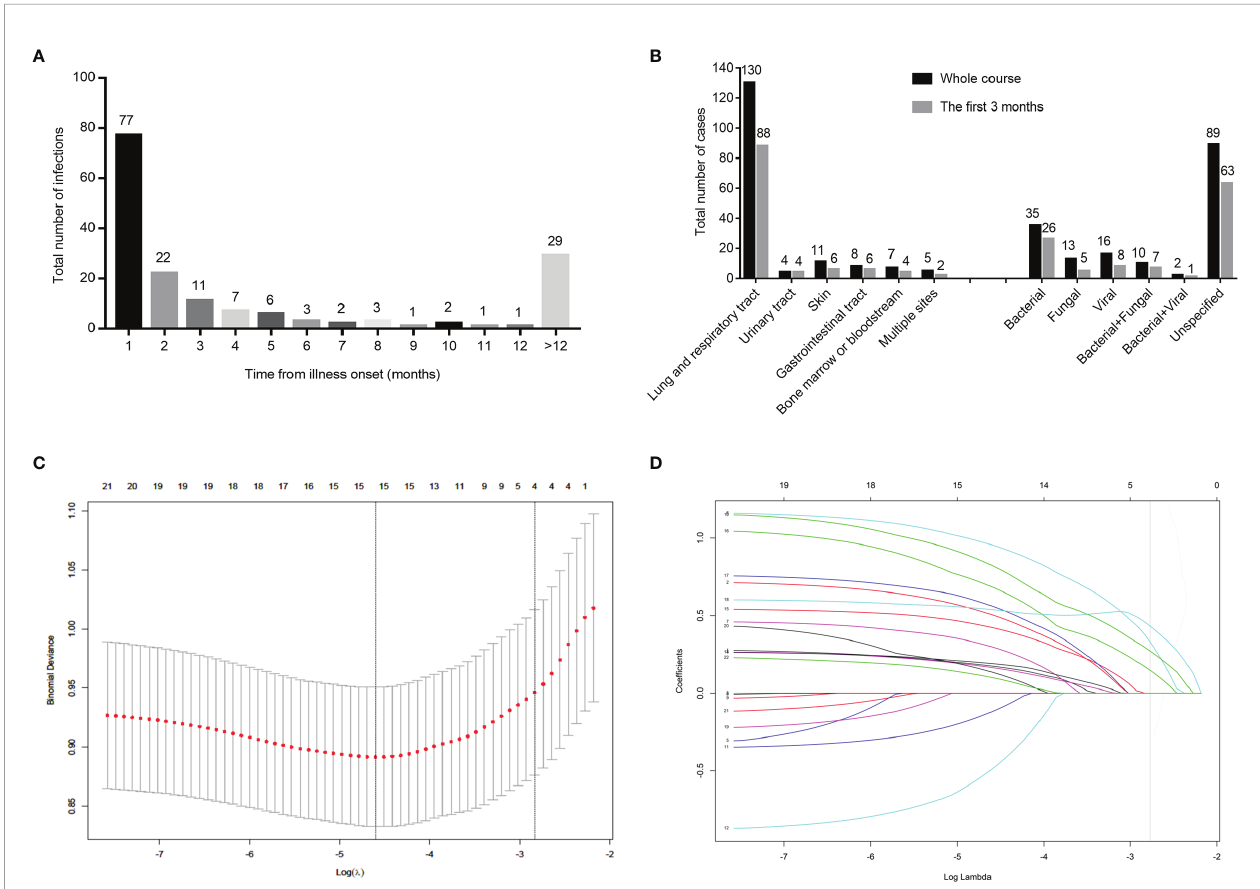
FIGURE 2 | Distribution of infection among540 patients in the training cohort and internal validation cohort, and clinical feature screening using LASSO binary logistic regression model in the training cohort. Number of infected cases monthly in 540 newly diagnosed multiple myeloma patients (A) . Number of patients with infections by the site of infection and species of pathogens (B) . Four variables selected by LASSO binary logistic regression analysis. Two dotted vertical lines indicate the optimal values by minimum criteria and 1-s.e. criteria (C) . LASSO coef fi cient pro fi les of the 24 variables. The vertical line indicates the optimal value based on the 1- s.e. criterion giving four non-zero coef fi cients (D) . LASSO, the Least Absolute Shrinkage and Selection